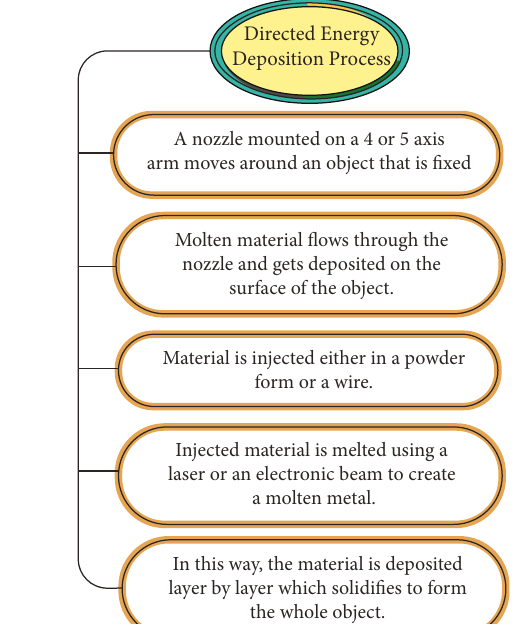
Figure 3: DED process